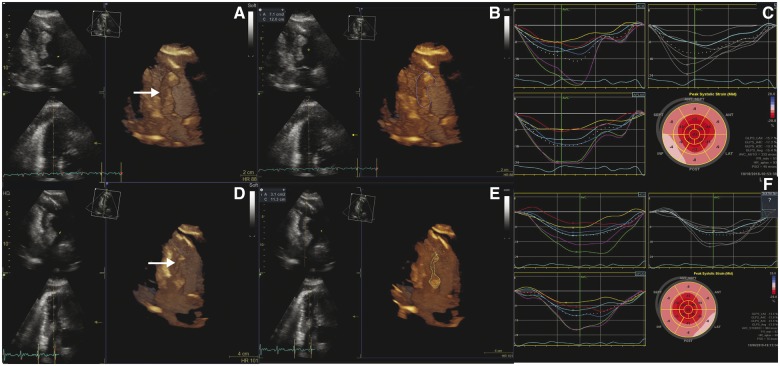
(A) Echocardiography before treatment with ipilimumab and nivolumab shows tumour in the right ventricle (arrow) with traced area of 7.1 cm2 (B). (C) Global longitudinal strain was reduced with apical sparing. (D) Echocardiography following third treatment with ipilimumab and nivolumab (6 weeks after treatment initiation) shows substantial regression in tumour size (arrow) with traced area reduced to 3.1 cm2 (E). No improvement in global longitudinal strain was noted at this time (F).